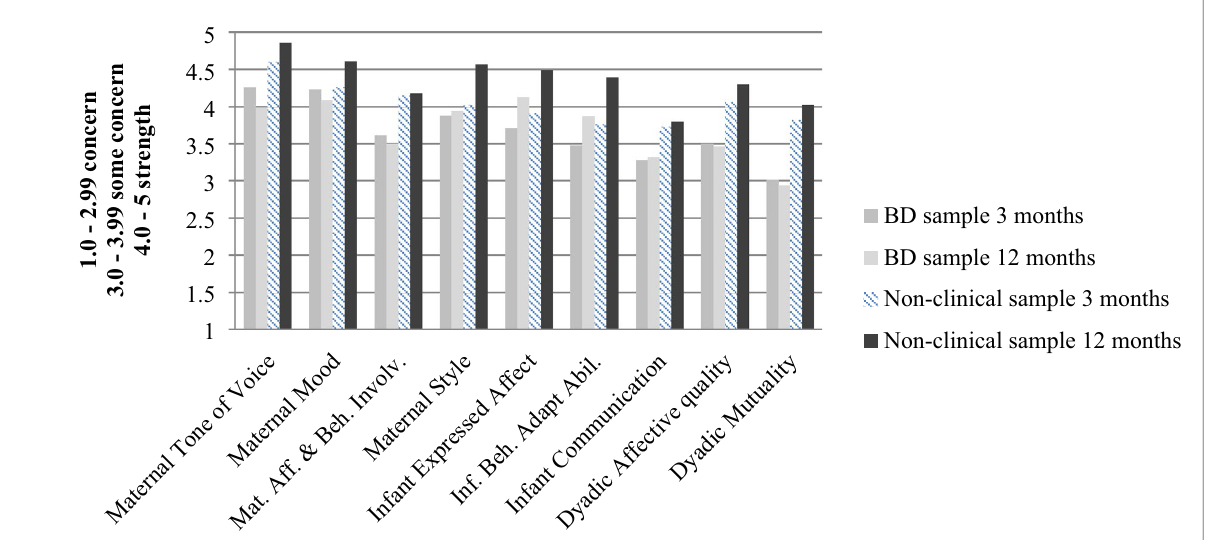
Fig. 2 Mean values on PCERA clustered subscales at 3 and 12 months for the BD and the non-clinical